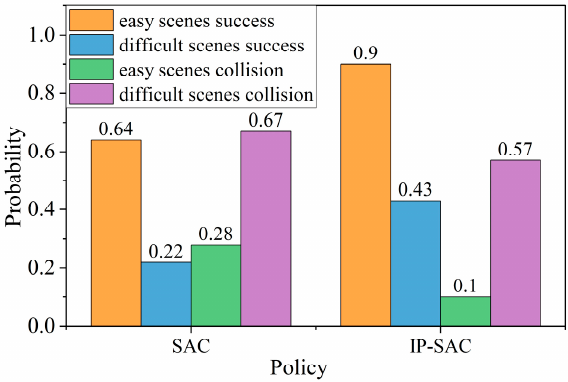
Figure 10. SAC and IP-SAC test results in easy and difficult scenarios.